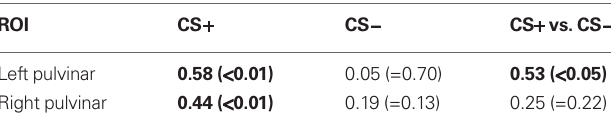
Table 2 | Trial-by-trial analysis of HiT vs. MiSS trials in the Pulvinar . Mean logistic slopes are provided ( P -values in parentheses; values in bold font are statistically significant at the 0.05